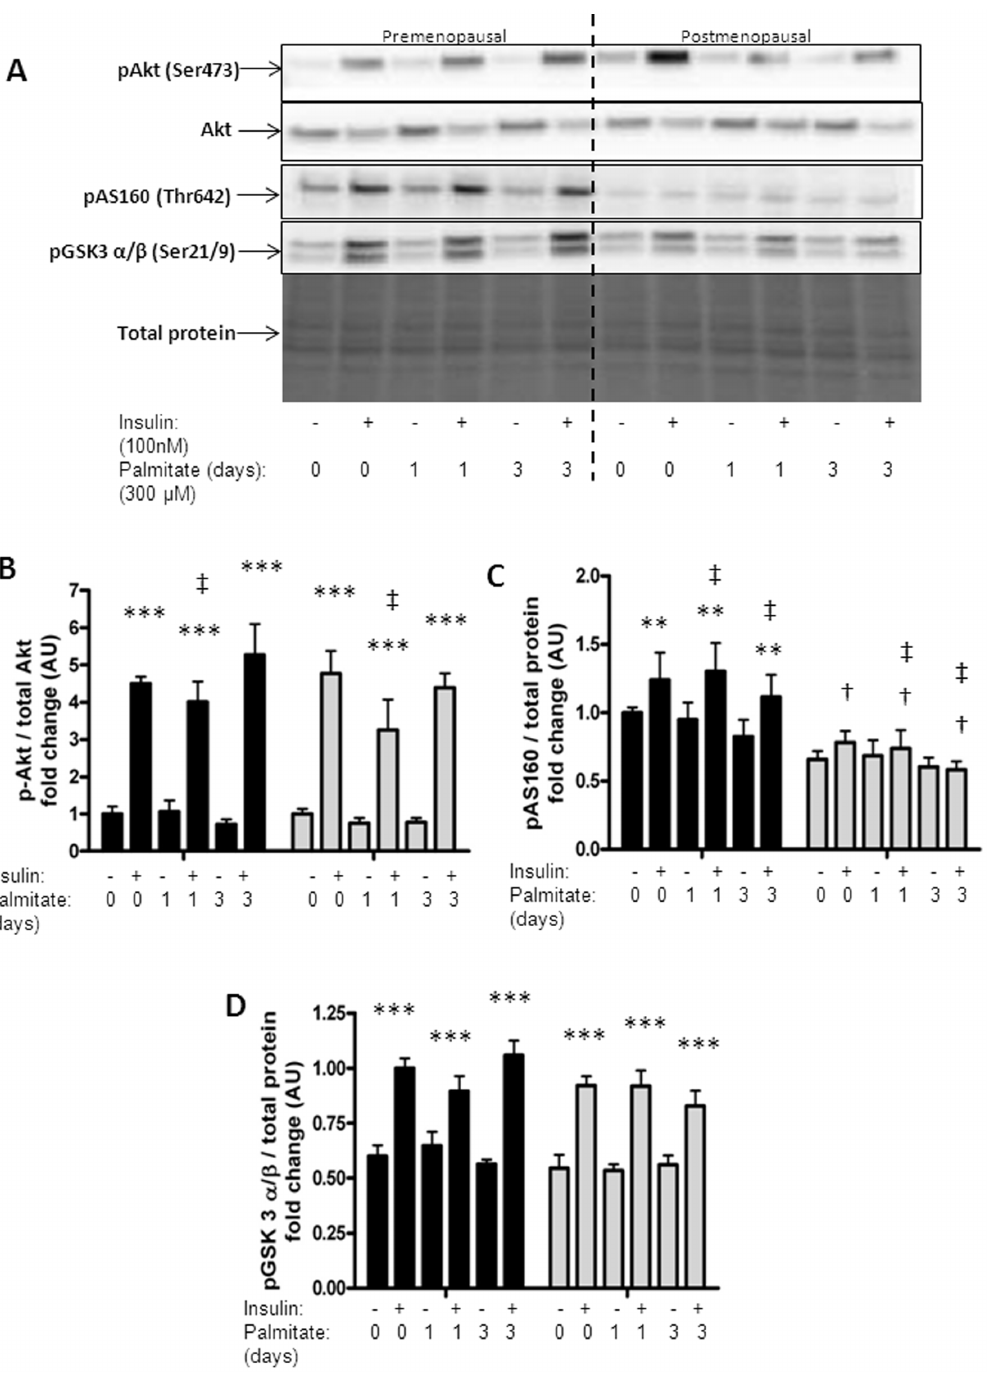
Figure 3. Protein expression in response to insulin in palmitate treated myotubes from premenopausal and postmenopausal women. Satellite cells were isolated from vastus lateralis biopsies from premenopausal and postmenopausal women. Cells were grown in culture until mature myotubes were formed. Myotubes were treated with palmitate (300 m M) in the last one or three days of differentiation as well as insulin (100 nM) for the last 15 minutes prior to the harvest. Protein lysates from the myotubes were immunoblottet to assess the protein expression of specific proteins as stated below. Protein expression in pre-myotubes (n=6, black bars) and post-myotubes (n=5, white bars, (A) representative blots of investigated proteins, (B) p-Akt-Ser473 (60 kDa) increased significantly in response to 15 minutes of insulin stimulation (100 nM). Furthermore, one day of palmitate treatment led to a significant decrease in insulin stimulated phosphorylation of Akt in the myotubes from all the women, (C) Palmitate treatment decreased insulin stimulated p-AS160-Thr642 (160 kDa) in both pre-myotubes and post-myotubes. Insulin stimulation had less of an effect on phosphorylation of AS160 in post-myotubes compared to pre-myotubes (insulin*menopause interaction), (D) p-GSK3 a / b -Ser21/9 (51/ 46 kDa) increased significantly in response to 15 minutes of insulin stimulation (100 nM) in both groups. Significant effect of insulin; ** p , 0.01, *** p , 0.0001. Significant effect of palmitate treatment; ` p , 0.05. Significantly different from premenopausal; { p , 0.05. 0: Zero days of palmitate treatment (control), 1: One day of palmitate treatment, 2: Two days of palmitate treatment, 3: Three days of palmitate treatment. All data were normalized to the premenopausal control group. Data are presented as means 6 SEM. doi:10.1371/journal.pone.0101555.g003 PLOS ONE |